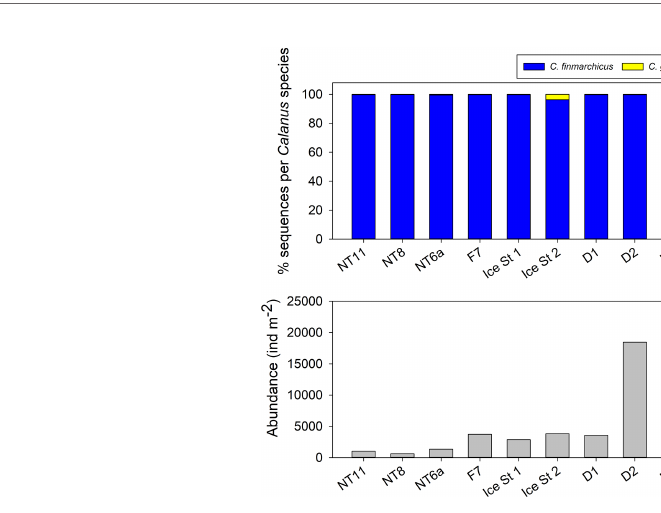
FIGURE 3 | Top: relative percentage of 16S sequences attributed to Calanus fi nmarchicus and Calanus glacialis in Bongo net samples. Bottom: abundance of Calanus between 3,000 and 6,000 µm prosome length in Bongo net samples as determined from Flowcam CMacro analysis.